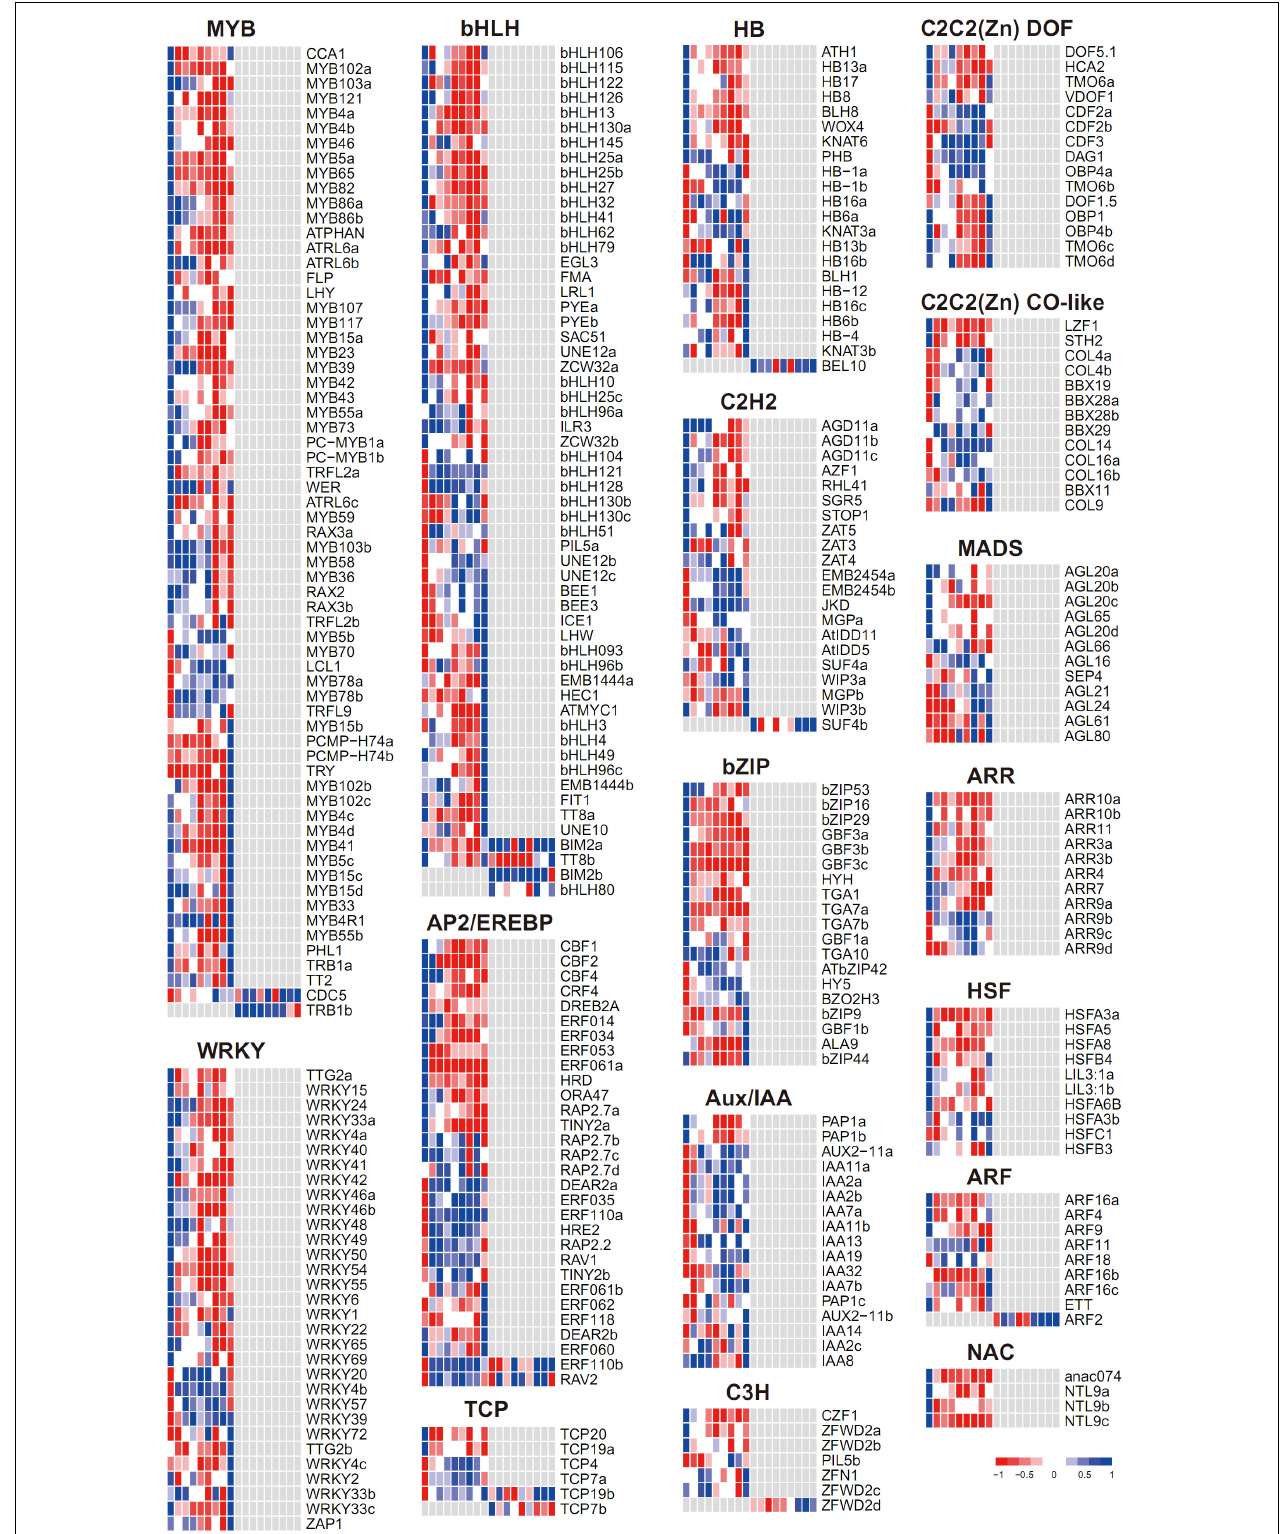
FIGURE 7 | Expression profiles of transcriptional factors during flooding stress. Each row represents a TF with its name at the right. The cells (from left to right) indicate the normalized expression value of R0, R6, R12, R18, R24, R30, R36, R48, and RR12 at the transcriptomic and proteomic levels, respectively.